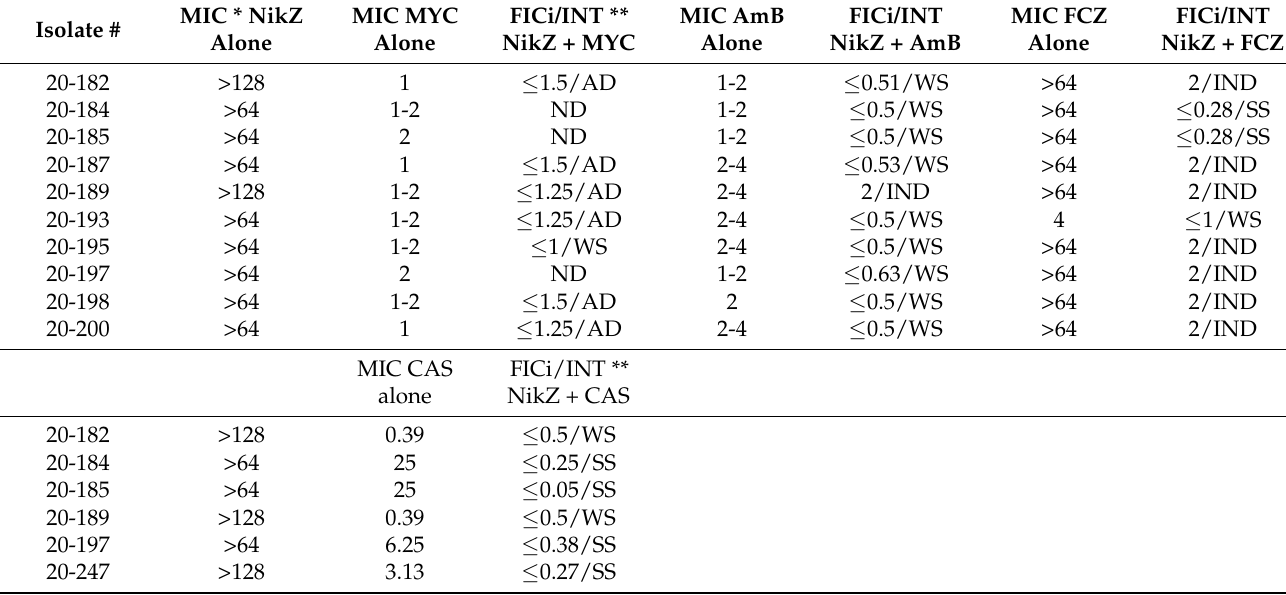
Table 2. Results of the minimal inhibitory concentration (MIC) of alone drugs and fractional inhibitory concentration index (FICi) of in vitro interaction between nikkomycin Z (nikZ) and micafungin